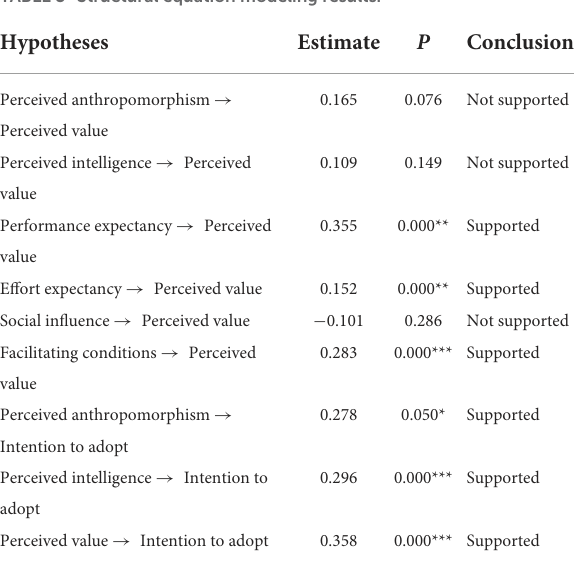
TABLE 5 Structural equation modeling